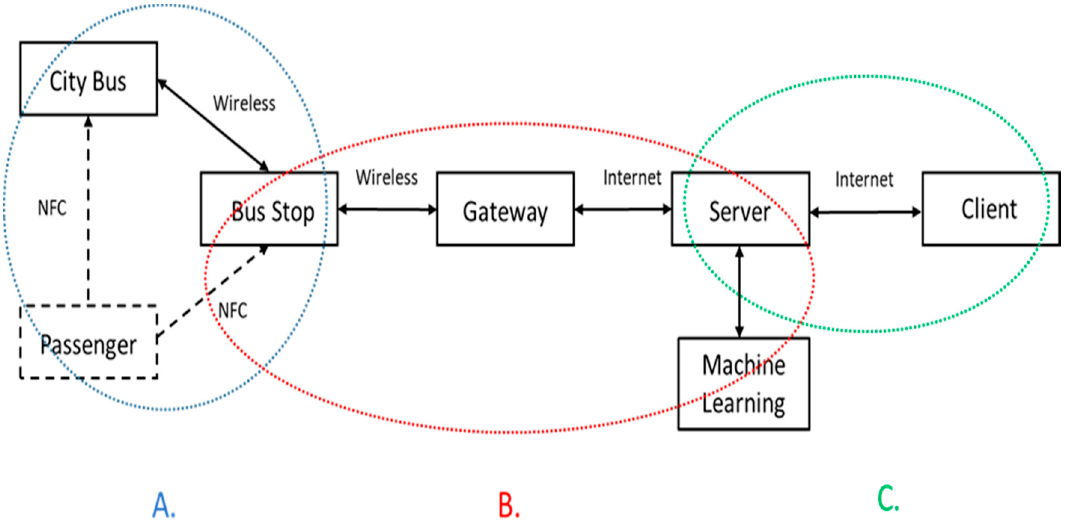
Figure 3. The system architecture: the dashed lines indicate the communication links related to passengers, and the solid lines indicate the communication links between each part of the system. Note that parts ( A ), ( B ), and ( C ) represent bus–station operations, station–gateway–server operations, and server–client operations, respectively.